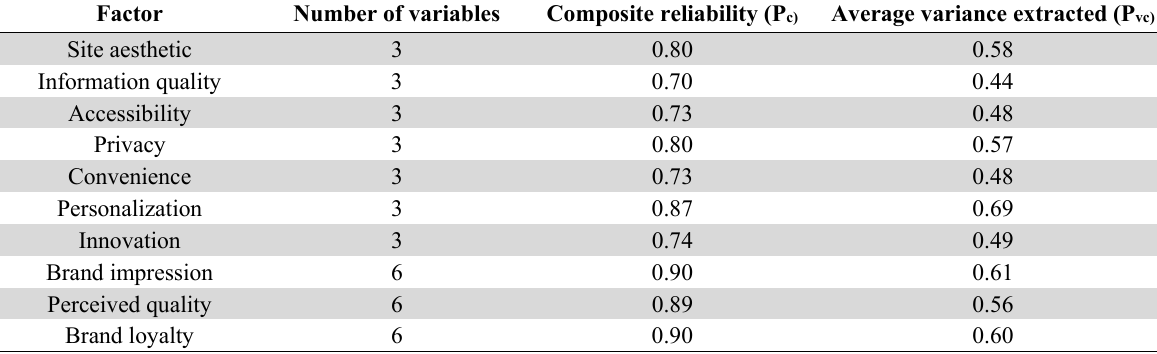
Result of composite reliability and average variance extracted Factor Number of variables Composite reliability (P c) Average variance extracted (P vc)